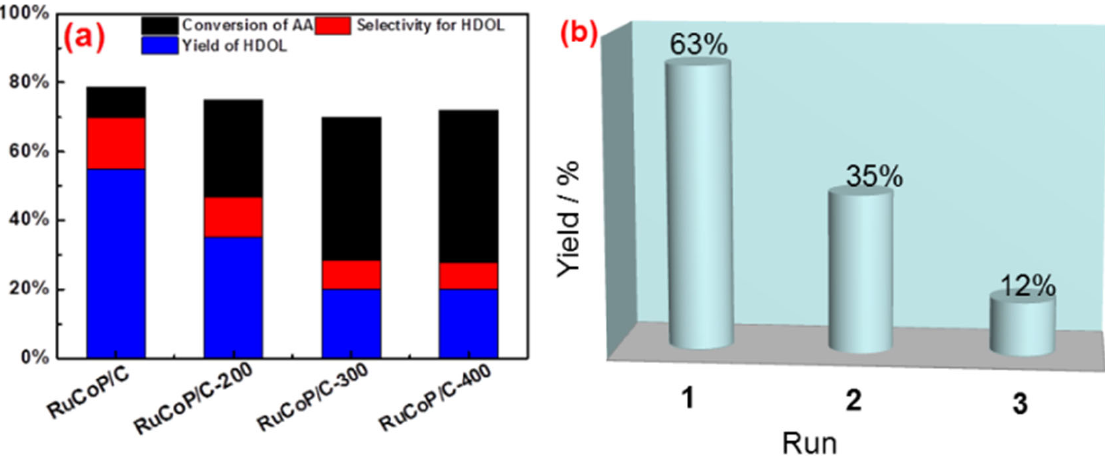
Figure 4. Hydrogenation of AA to HDOL on RuCoP/C, RuCoP/C ‐ 200, RuCoP/C ‐ 300, and RuCoP/C ‐ 400 ( a ); stability of the amorphous RuCoP/C catalyst in hydrogenation of AA to HDOL ( b ).